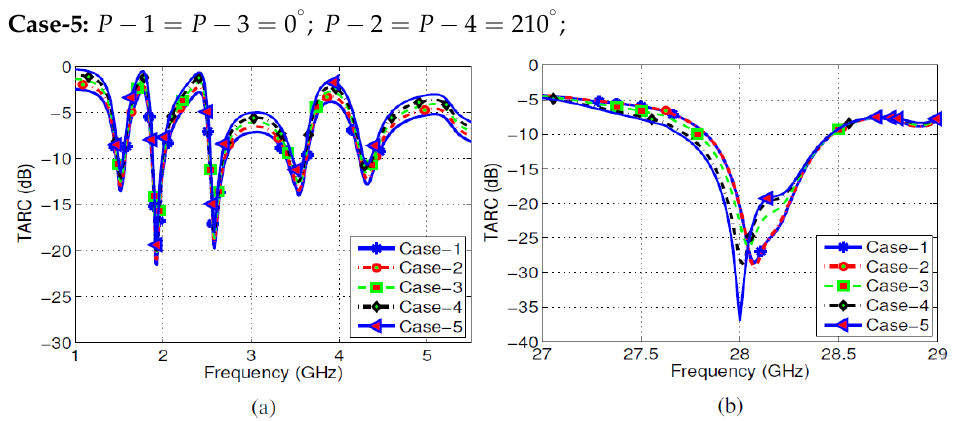
Figure 16. TARC curves: ( a ) sub-6GHz, ( b ) millimeter-wave band.